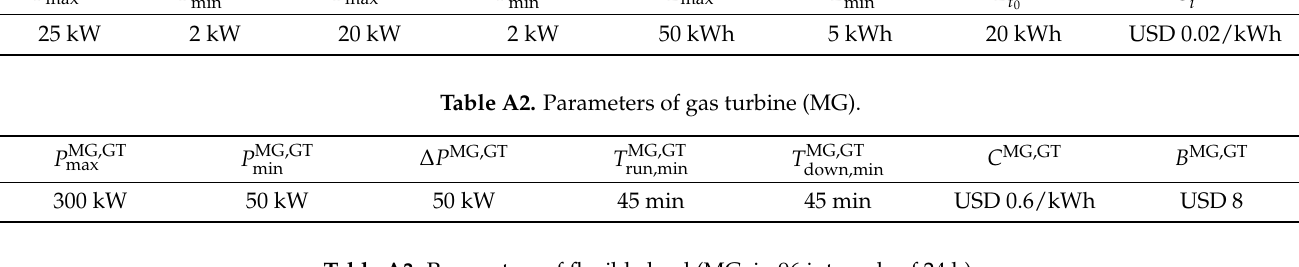
Table A3. Parameters of flexible load (MG, in 96 intervals of 24 h).